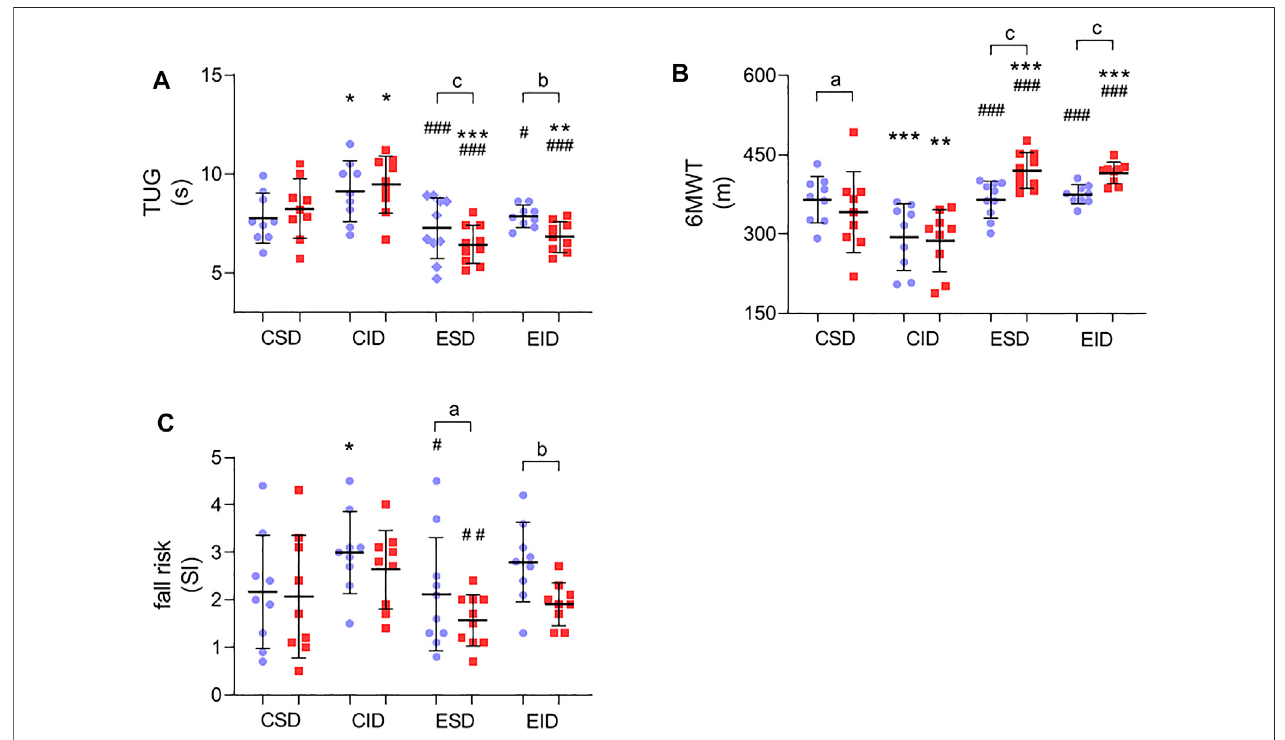
FIGURE 2 | Post-training changes in physical performance and fall risk. (A) Time up and go test; (B) 6-minute walk test; (C) fall risk test. There were signi fi cant differencesbetweentheindicatedtimepoints: a – p < 0.05, b – p < 0.01, c – p < 0.001;betweenthegroups:* p < 0.05,** p < 0.01,*** p < 0.001vs.CSD;# p < 0.05,## p < 0.01; ### p < 0.001 vs. CID. The data are presented as the means ± SEM; plain — before the intervention; strips — after the intervention.